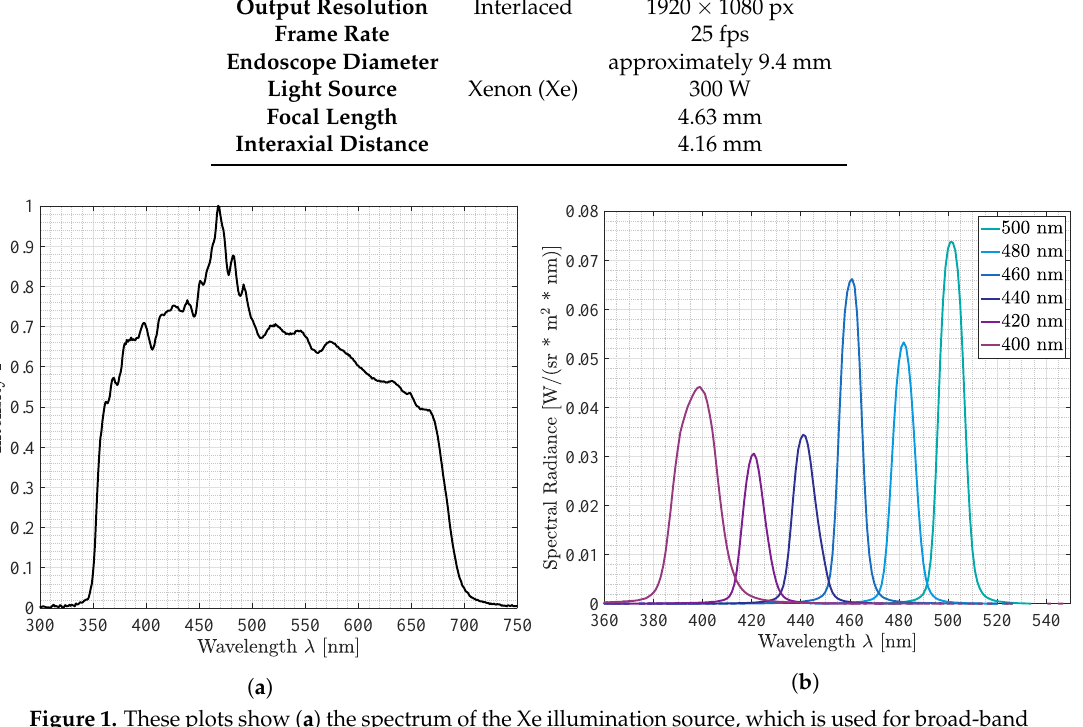
Figure 1. These plots show ( a ) the spectrum of the Xe illumination source, which is used for broad-band illumination of the situs, as well as ( b ) the six filters used from 400 nm to 500 nm for the narrow-band illumination mode. The Xe light source ( a ) contains cut-off filters at λ = 350 nm, as well as λ = 700 nm, and the illumination intensity I is normalized. In ( b ), the specific spectral radiance for each filter is presented to show the differences between the filter